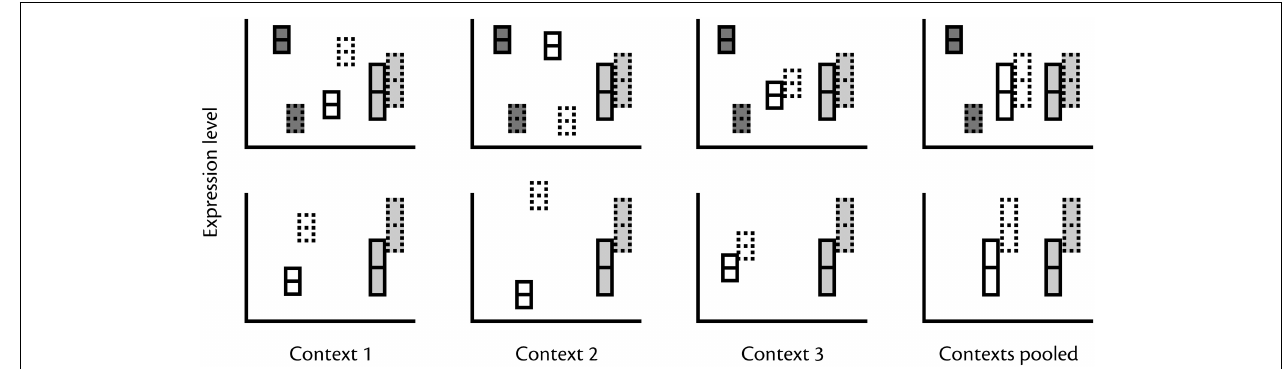
FIGURE 2 | Why variability in expression pattern may be difficult to interpret. Boxes with solid and dotted outlines refer to expression in two different morphs. Top row: Within contexts gene expression that are consistently morph biased (dark gray boxes) or morph biased in a context-dependent manner (e.g., body size, age, past or current social experience) (white boxes) will show a morph